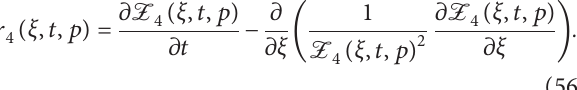
Figure 1 for Test Problem 4.1.